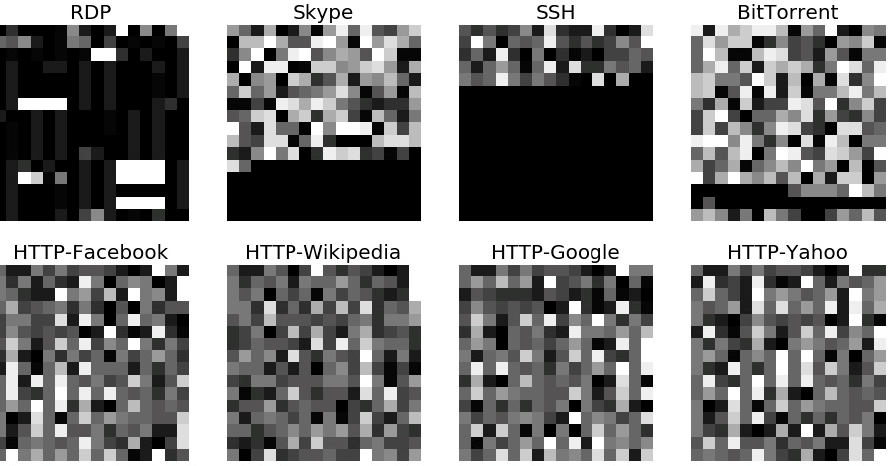
Figure 2. Sampled images of network packets extracted from the Packet Capture (PCAP) data.